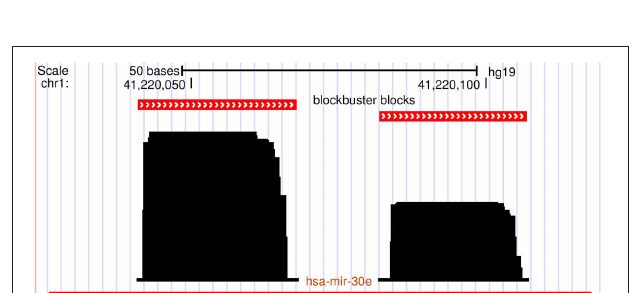
FIGURE 1 | A characteristic read profile (block group) for microRNA in the human genome. It is dominated by two distinct clusters of reads (blocks) with almost similar start and/or end positions. These read profiles are in many cases influenced by secondary structures of the parent transcript and may convey information about the processing mechanism of the transcript like dicer cleavage in this